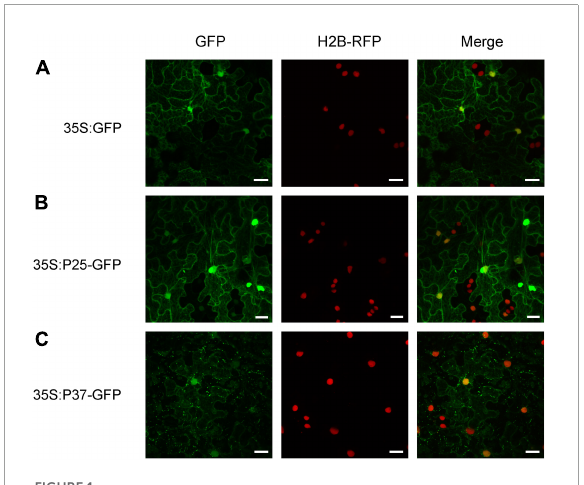
FIGURE1 Sublocalization of the P25 and P37 proteins of firespike leafroll-associated virus (FLRaV). (A) Localization of green fluorescent protein (GFP) in H2B-RFP Nicotiana benthamiana leaf epidermal cells at 48 h post infiltration (hpi). (B) Localization of FLRaV P25-GFP fusion protein in H2B-RFP N. benthamiana leaf epidermal cells at 48 hpi. (C) Localization of FLRaV P37-GFP fusion protein in H2B-RFP N. benthamiana leaf epidermal cells at 48 hpi. Histone 2B-RFP (H2B-RFP) was served as a marker for the nucleus. Bar = 20 µ m. Images are reconstructed by superposition of a series of confocal optical